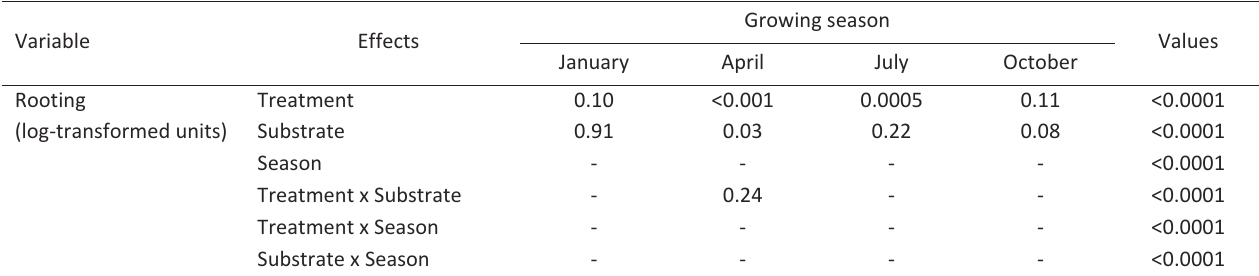
Table 1 ­ Results of the multifactor ANOVA to analyze the effects of the main factors on the rooting performance of cuttings across the four seasons Variable Effects Rooting